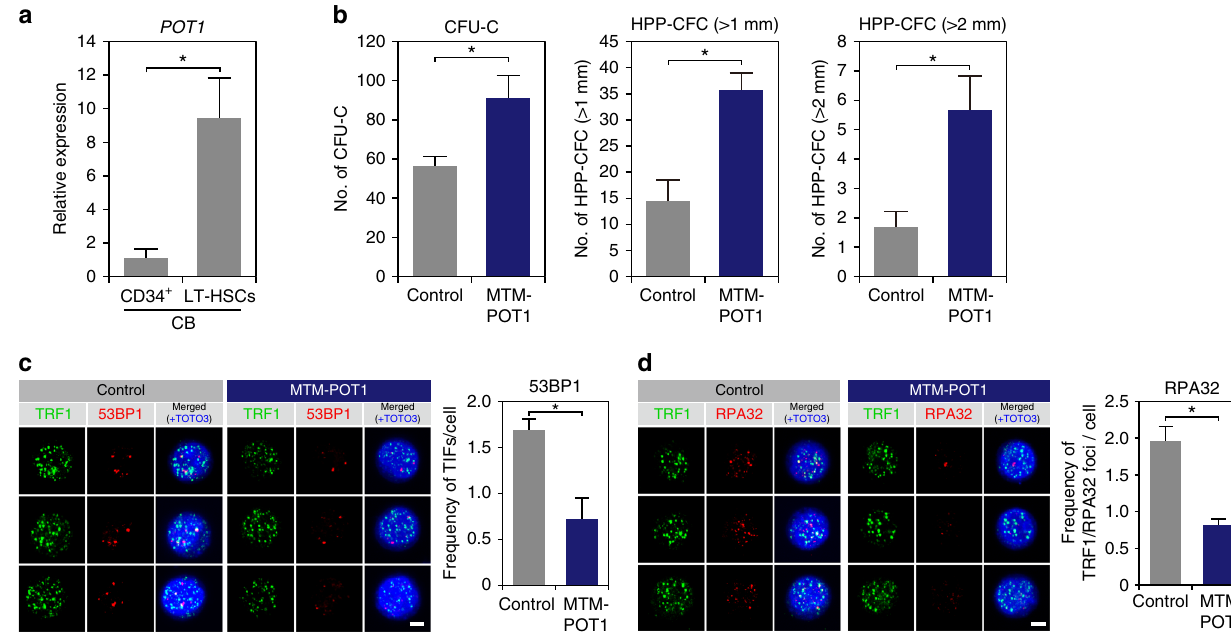
Fig. 9 POT1 prevents DDR in human HSC. a Expression of POT1 in hCB CD34 + cells and LT-HSCs (Lin – CD34 + CD38 − CD45RA − CD90 + CD49f + ). b hCB-derived LT-HSCs were cultured with MTM-POT1. After 10 days of culture, cells were isolated and re-cultured in methylcellulose medium (200 cells per dish). The number of CFU-C and HPP-CFC ( > 1.0 mm, > 2.0 mm) are shown. Data are expressed as the mean ± SD ( n = 3, * p < 0.01 by t -test). Representative data from three independent experiments are shown. c , d hCB LT-HSCs were cultured for 10 days with control MTM protein or MTM-POT1. After 10 days of culture, LT-HSCs were re-isolated and number of TIF was examined. c Immunocytochemical staining of TRF1 ( green ), 53BP1 ( red ), and TOTO3 ( blue ). Scale bar , 2 μ m ( left ). Frequencies of TIFs after 10 days of culture ( right ). Data are expressed as the mean ± SD ( n = 100: control, n = 100: MTM-POT1, * p < 0.01 by t -test). Representative data from 2 independent experiments are shown. d Immunocytochemical staining of TRF1 ( green ), RPA32 ( red ), and TOTO3 ( blue ). Scale bar , 2 μ m ( left ). Frequencies of TIFs after 10 days of culture ( right ). Data are expressed as the mean ± SD ( n = 110 – 120: control, n = 110: MTM-POT1, * p < 0.01 by t -test). Representative data from two independent experiments are